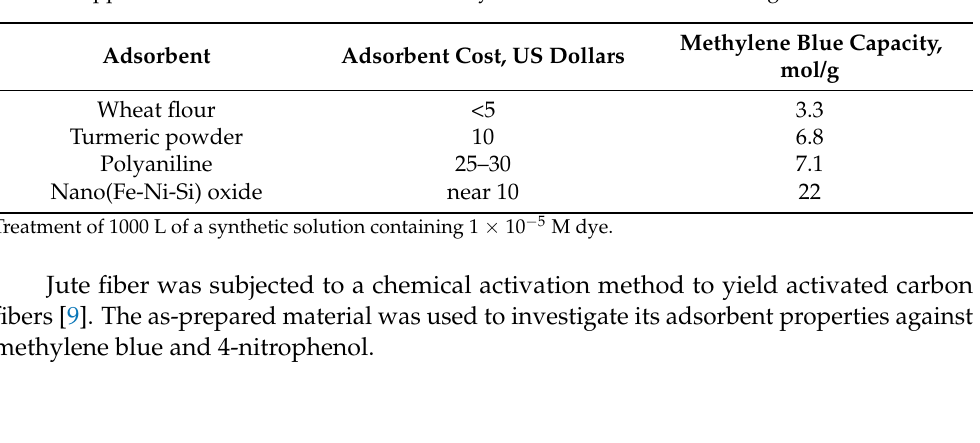
Table 8. Approximate costs in the removal of methylene blue from solutions using various